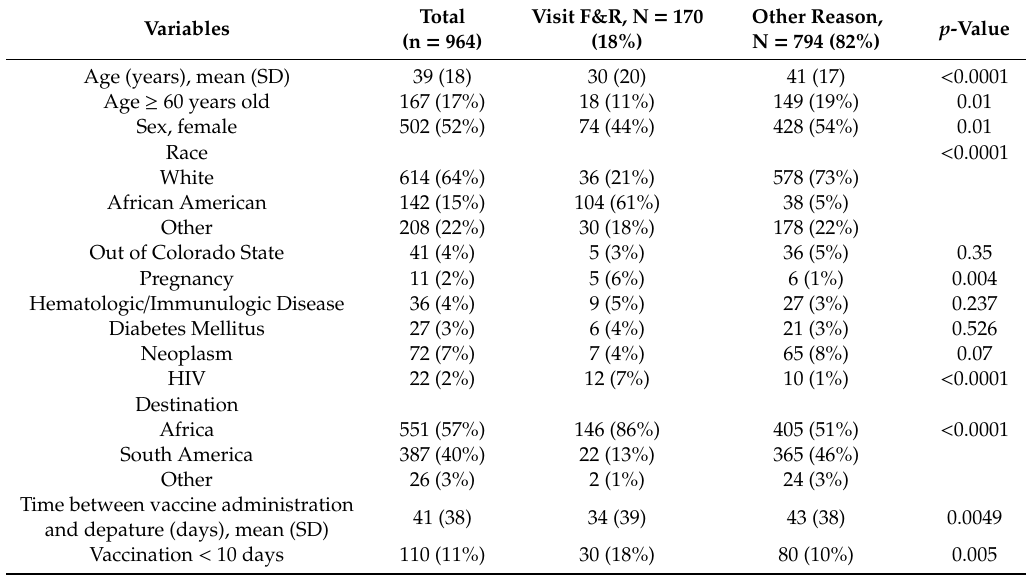
Table 1. A cohort of travelers receiving the yellow fever vaccine at the University of Colorado